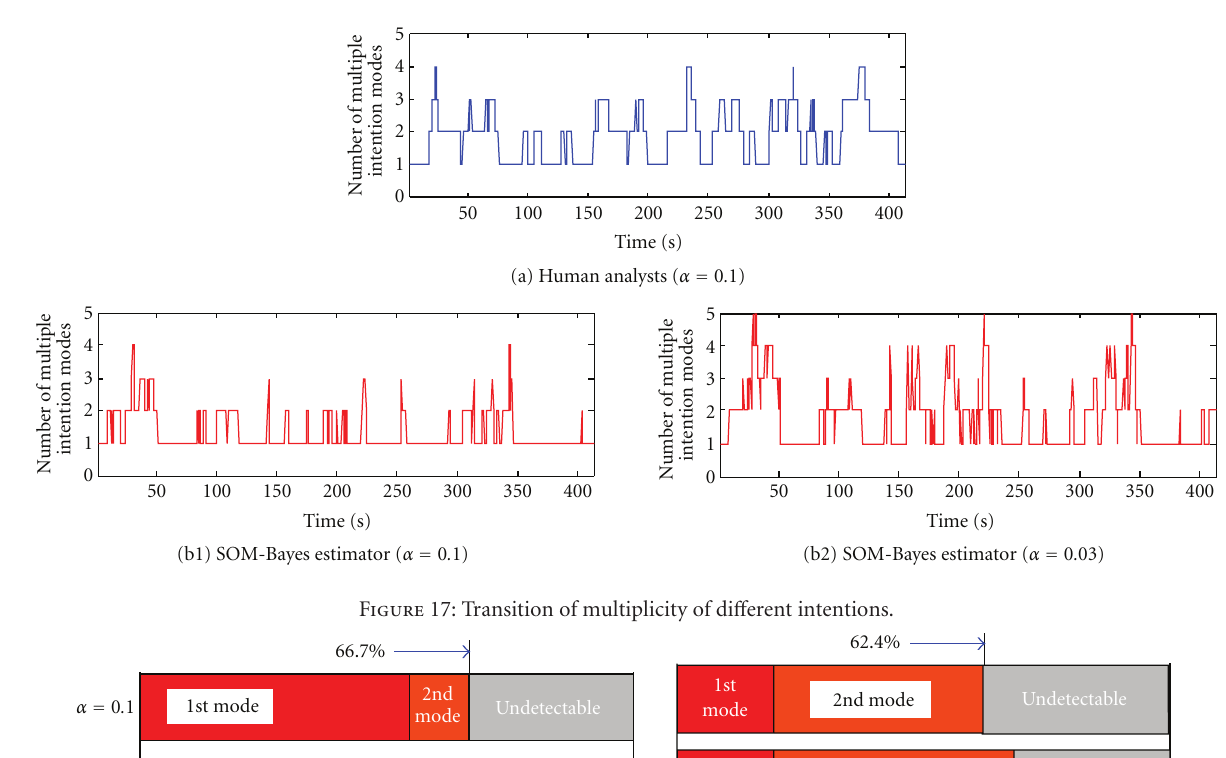
Figure 17: Transition of multiplicity of di ff erent intentions.